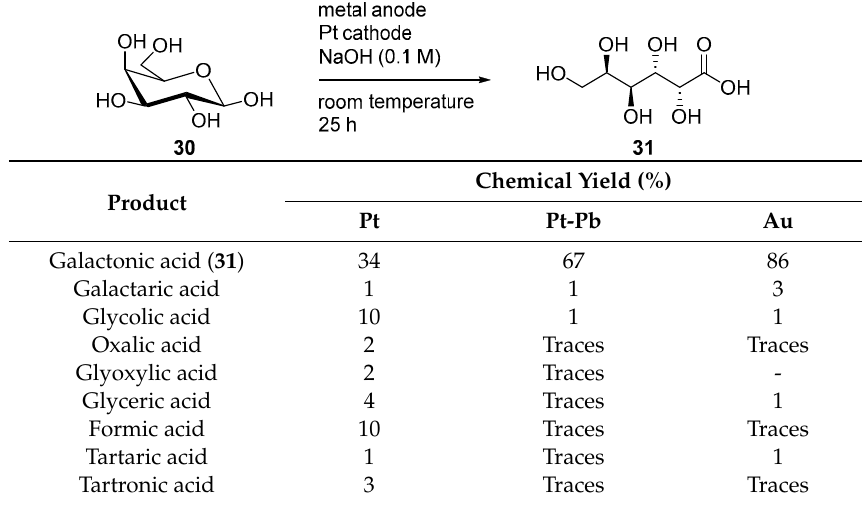
Table 6. Direct electro-oxidation of d -galactose.